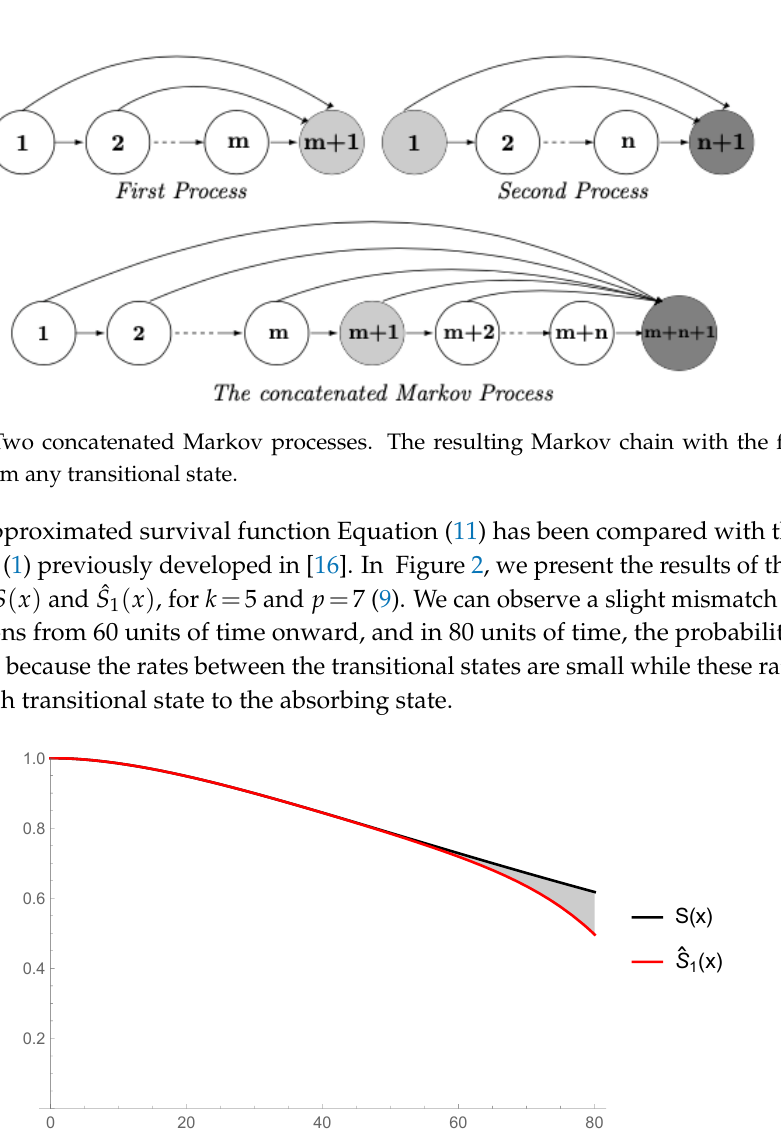
Figure 2. Survival function, S ( x ) , and the first approximation, ˆ S 1 ( x ) , in the concatenated Markov process for p = 7 with simulated data from a uniform